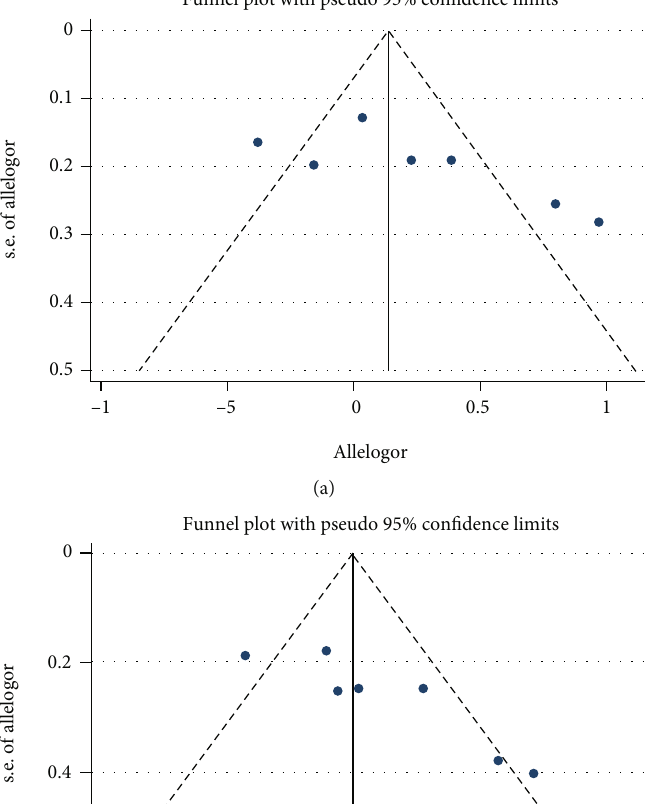
Funnel plot with pseudo 95% confidence